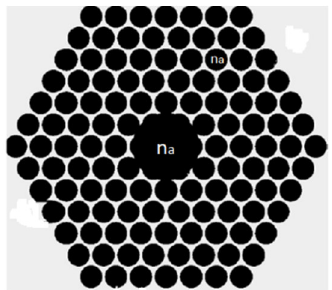
Figure 38. Microscope image of the three holes PCF with suspended Ge-doped silica core. It is combined with fiber Bragg grating and holes are filled with analyte then used as refractive index sensor (Reproduced from [107], with the permission of OSA publishing).